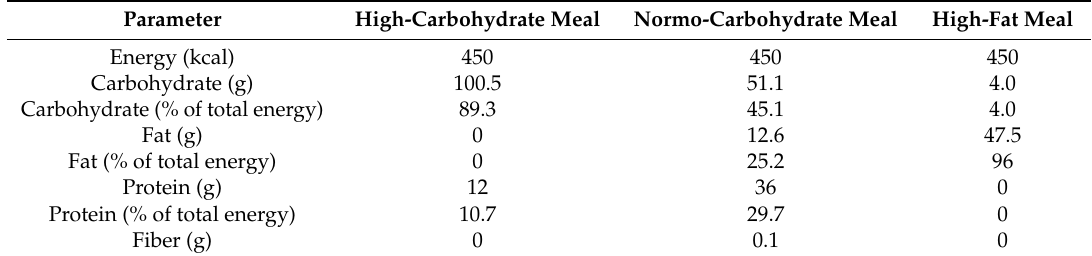
Table 2. The energy and macronutrients composition of meals.